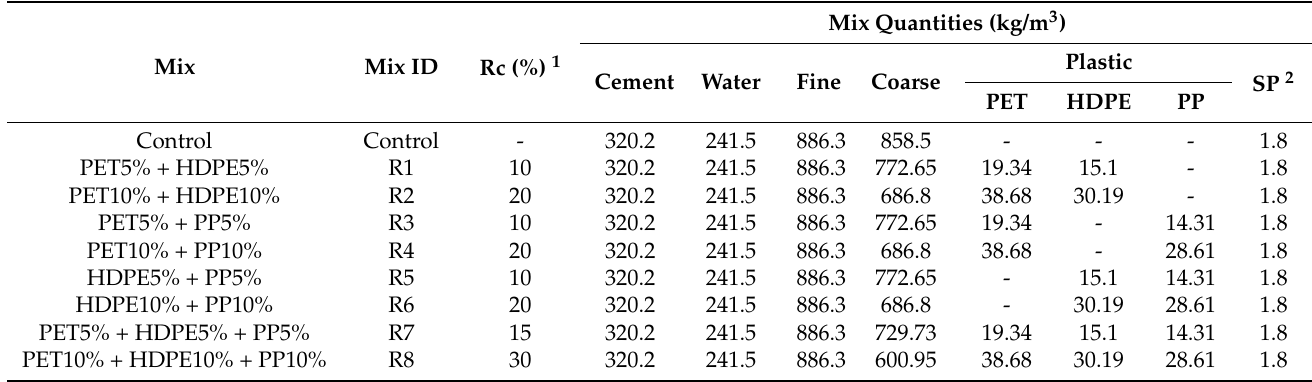
Table 1. Mix proportions for cement